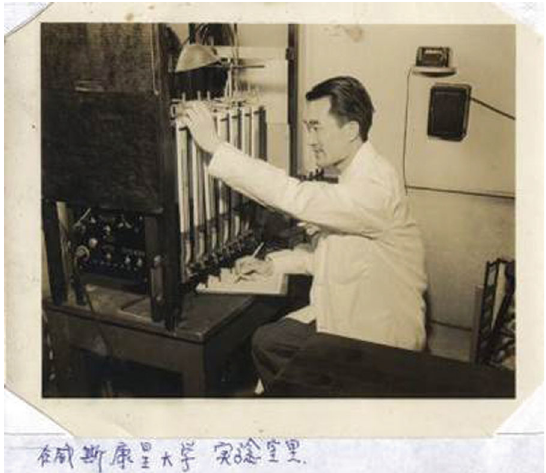
Figure 4. Working with a gas exchange testing machine at the University of Wisconsin-Madison for his PhD